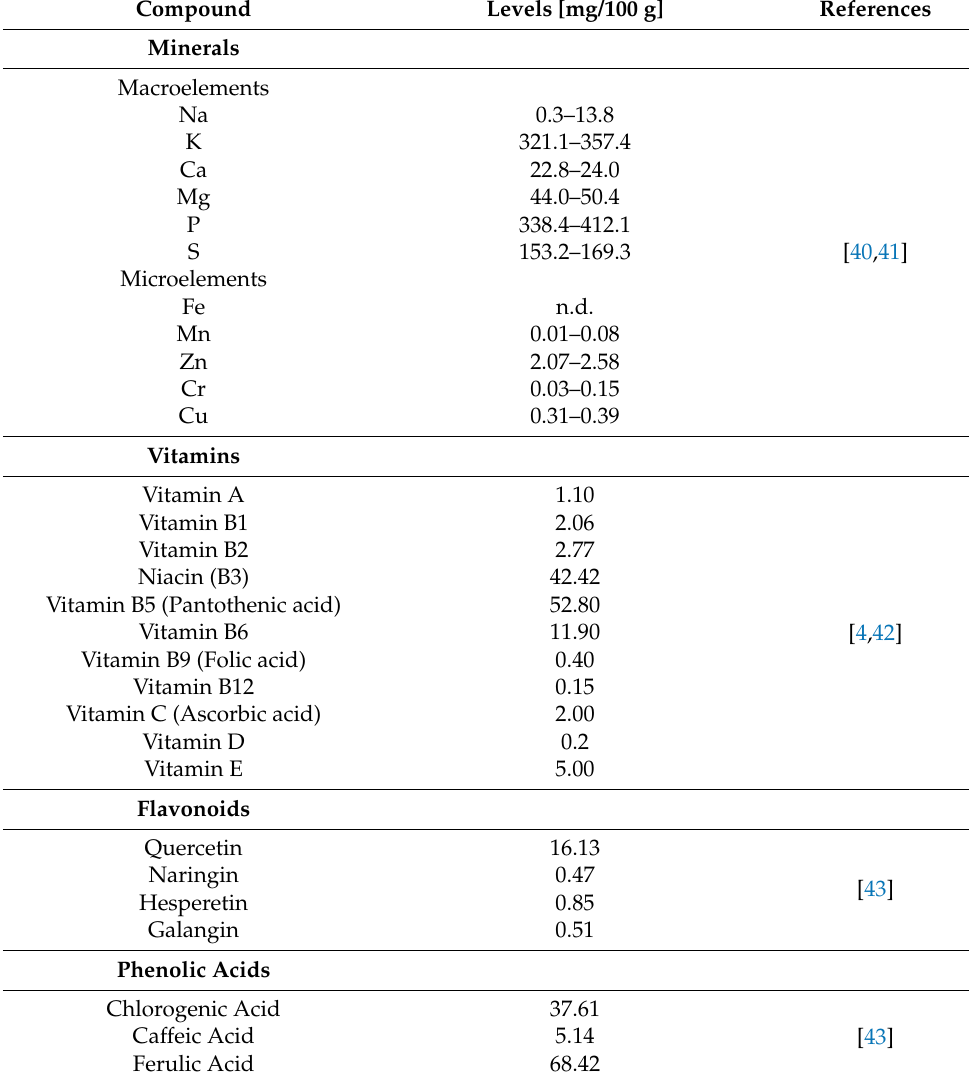
Table 2. Proximate composition of fresh